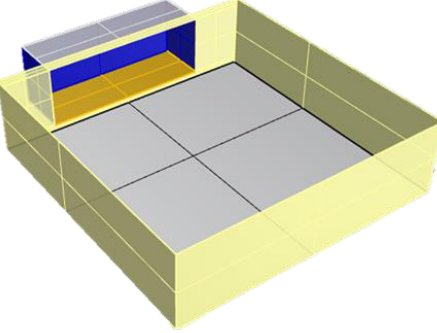
Figure 5. The basic spatial form. Table 2. Setting conditions of parametric model.